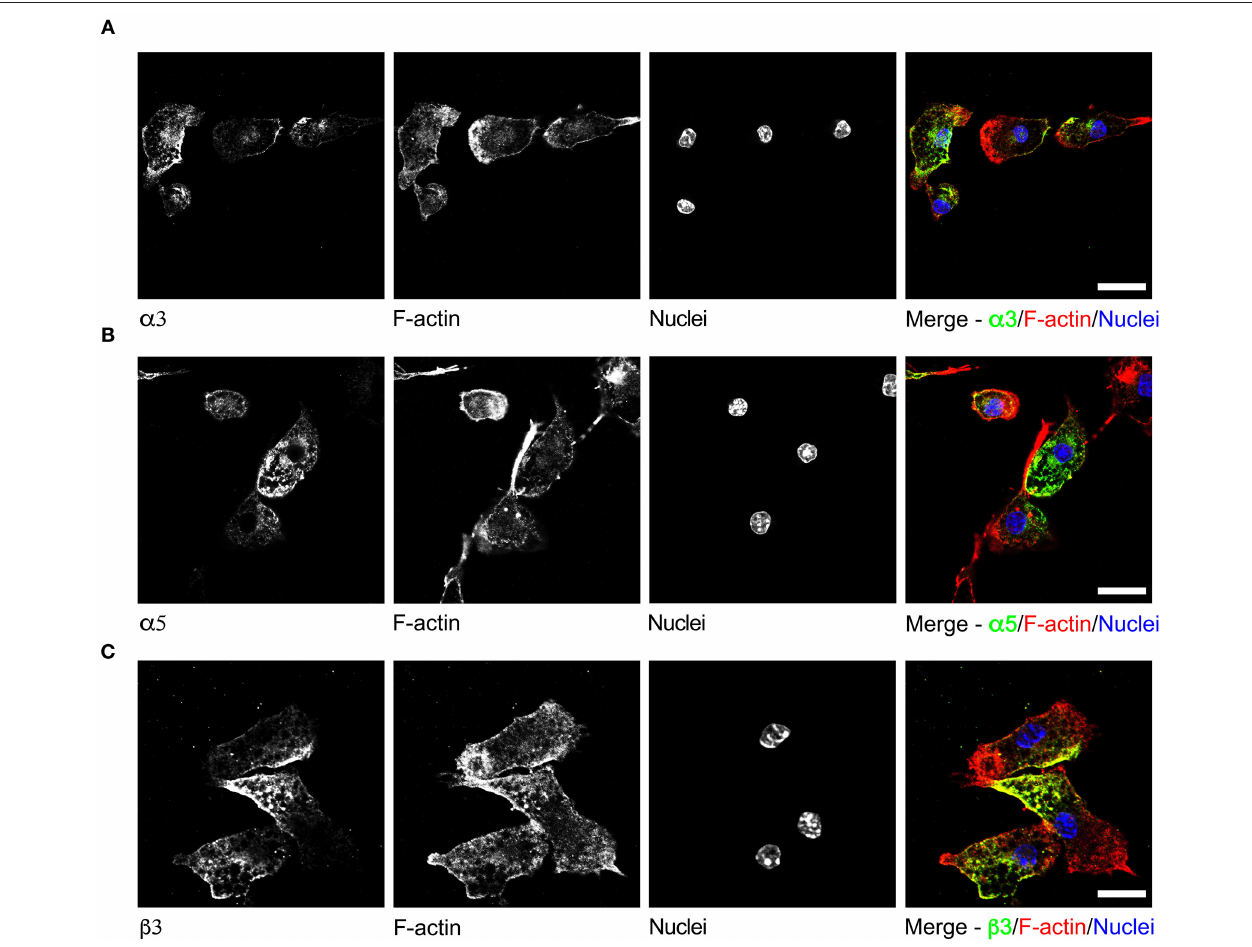
FIGURE 3 | Immunostaining of GABA-A R subunits in primary microglia. Representative micrographs of unchallenged primary microglia stained with antibodies against GABA-A R (A) α 3 subunit, (B) α 5 subunit, and (C) β 3 subunit, respectively, together with Alexa Fluor 647 Phalloidin (F-actin) and DAPI (nuclei), as indicated under Materials and Methods. Representative data is shown from 4 independent experiments. Scale bars, for (A,B) = 10 µ m, for (C) = 5 µ